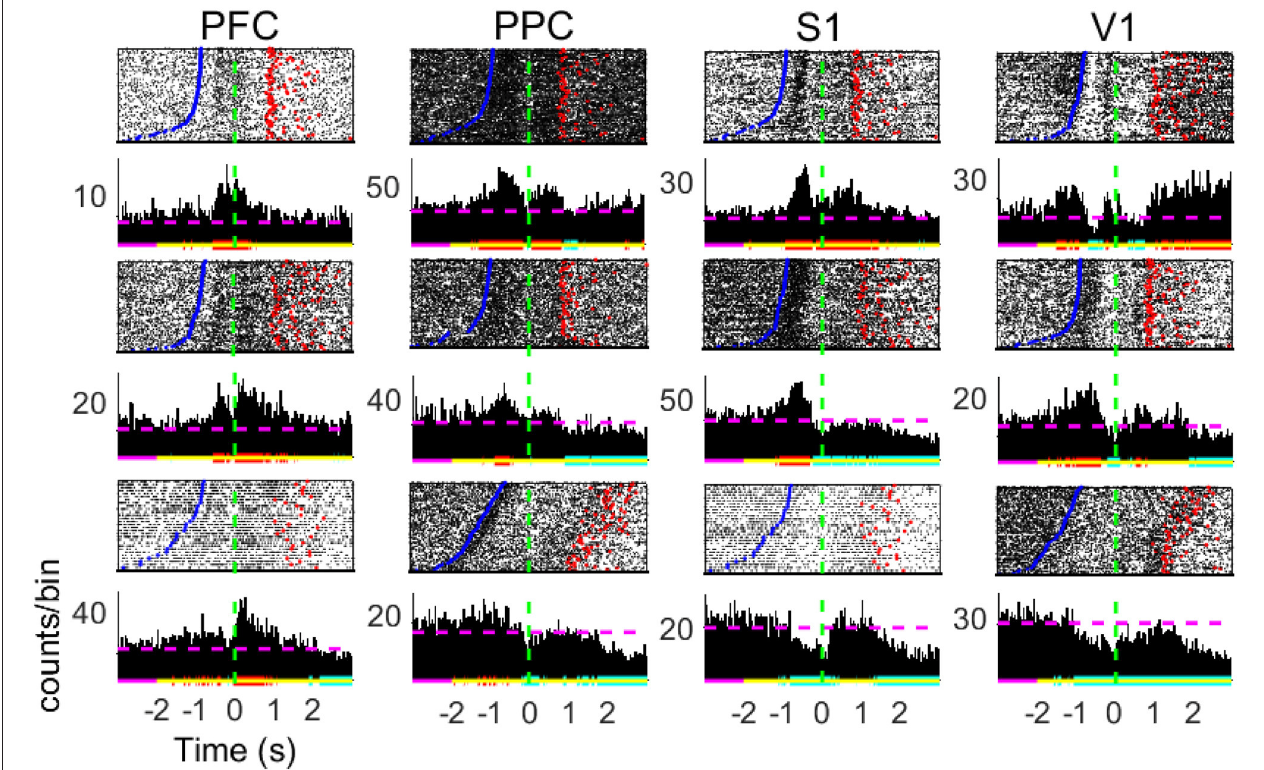
FIGURE 3 | Peri-stimulus time histograms of neuronal responses of single cells. Panels show 3 representative neurons from diverse subjects in each of the brain regions recorded. Neuronal data was binned using a sliding 10 ms time-window (no overlap). The baseline neural activity is defined as the [ horizontal lines indicate significant increase (decrease) in firing modulations; purple (yellow) lines relate to the baseline (analyzed) period; dashed horizontal lines depict the MFR in the whole period. Time t 0 mark the moment rats reach the NP (dashed green horizontal line). Blue points indicate the beginning of trials (Central Door) = and red points indicate the water reward delivery.